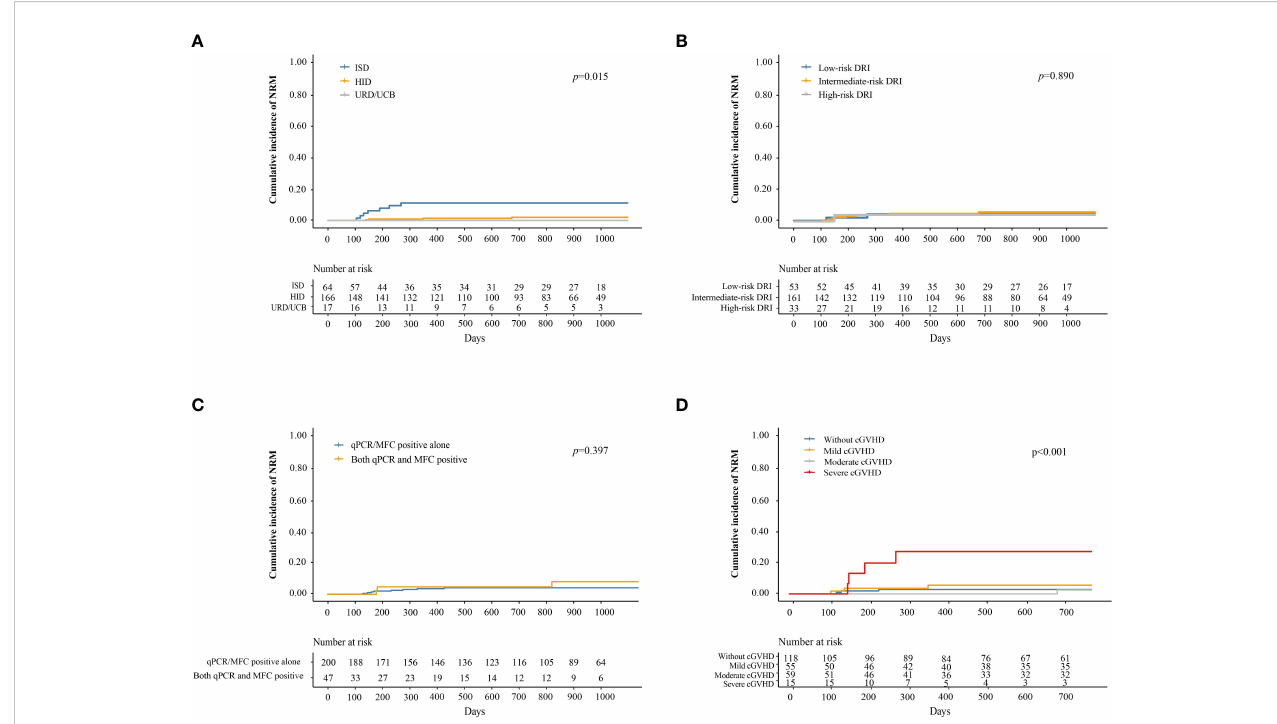
FIGURE 4 Cumulative incidence of NRM after preemptive IFN- a therapy for patients receiving ISD, HID, and URD/UCB transplantation (A) , for patients in the low-, intermediate-, and high-risk DRI groups (B) , for patients with qPCR/MFC positive alone and both qPCR and MFC positive (C) , and for patients without cGVHD, with mild, moderate, and severe cGVHD (D) . NRM, non-relapse mortality; IFN- a , interferon- a ; ISD, identical sibling donor; HID, haploidentical donor; URD, unrelated donor; UCB, unrelated cord blood; qPCR, quantitative polymerase chain reaction; MFC, multiparameter fl ow cytometry; DRI, disease risk index; cGVHD, chronic graft-versus-host